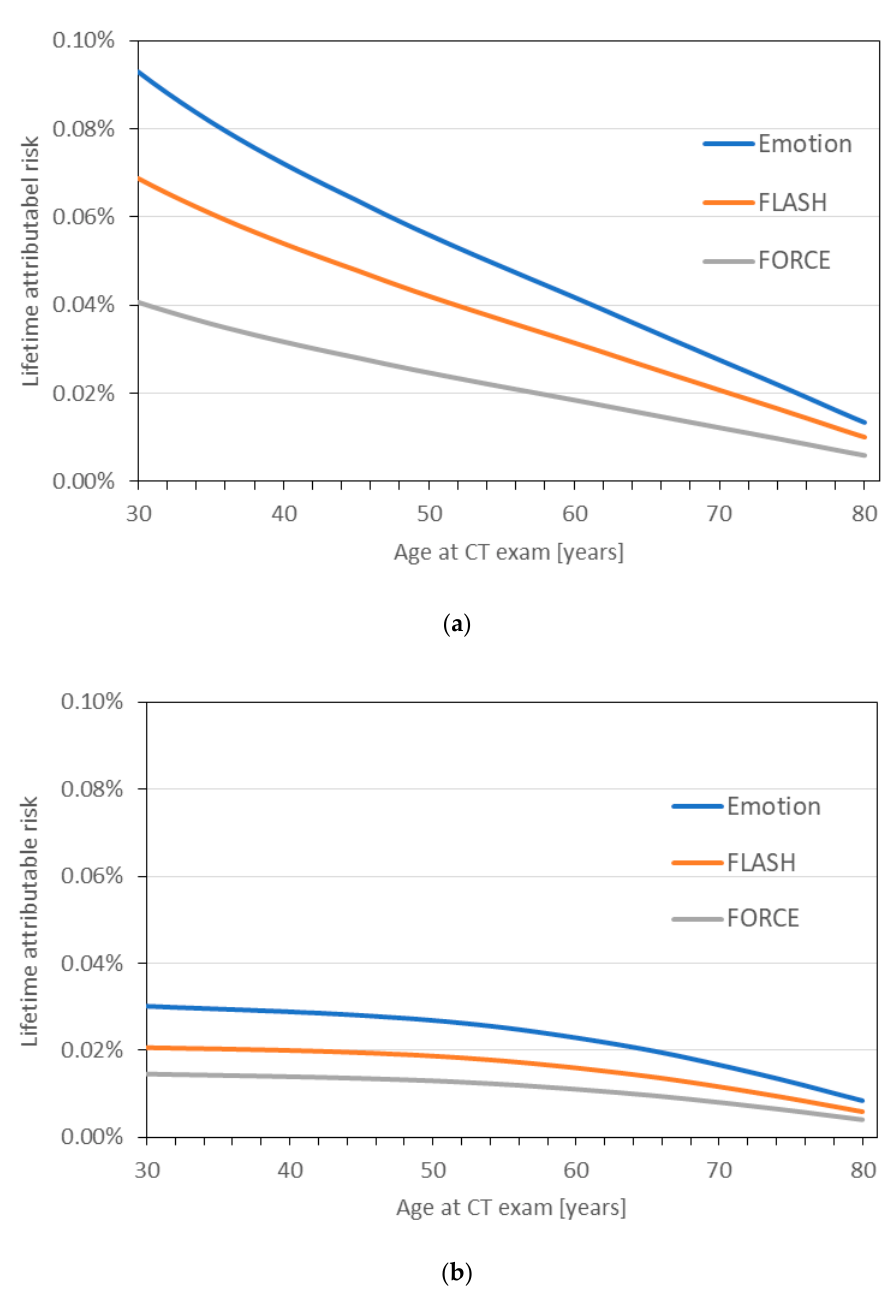
Figure 6. Lifetime attributable cancer risk (LAR) for ( a ) female and ( b ) male reference patient undergoing either inspiration-only chest scans at the MSCT and 2nd-DSCT or a paired inspiratory-expiratory scan at the 3rd-DSCT (incidence data).